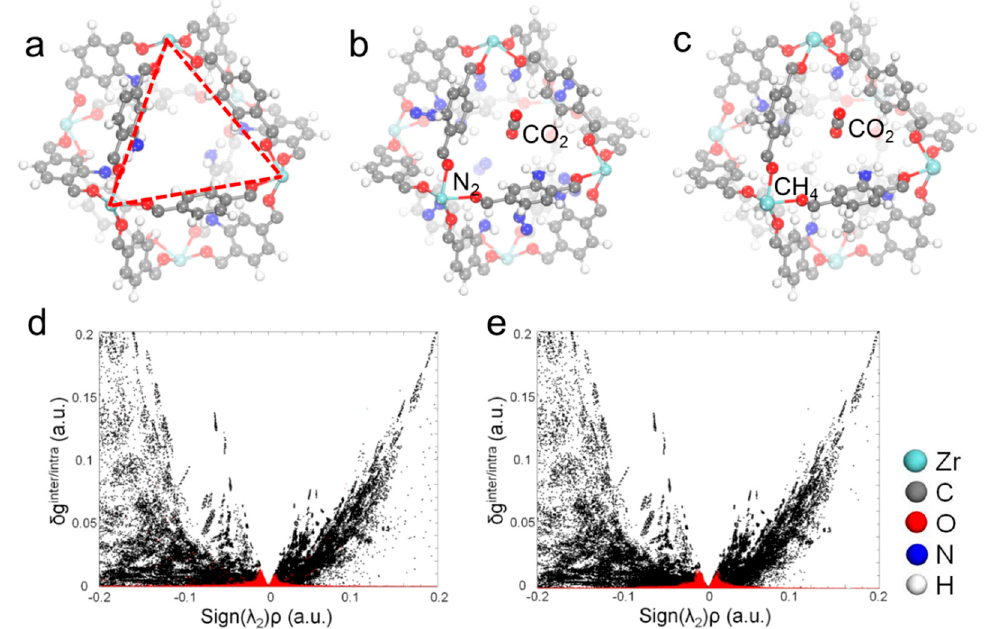
Figure 7. Optimized structures and intermolecular interactions between CO 2 , N 2 and CH 4 . Stable porous cage structure of UiO-66-NH 2 ( a ), stable adsorption structure for CO 2 and N 2 adsorption in UiO-66-NH 2 ( b ), stable adsorption structure for CO 2 and CH 4 adsorption in UiO-66-NH 2 ( c ), scatter plot for δ function versus sign( λ 2 ) ρ of CO 2 and N 2 ( d ) and CO 2 and CH 4 ( e ) adsorption in UiO-66-NH 2 .